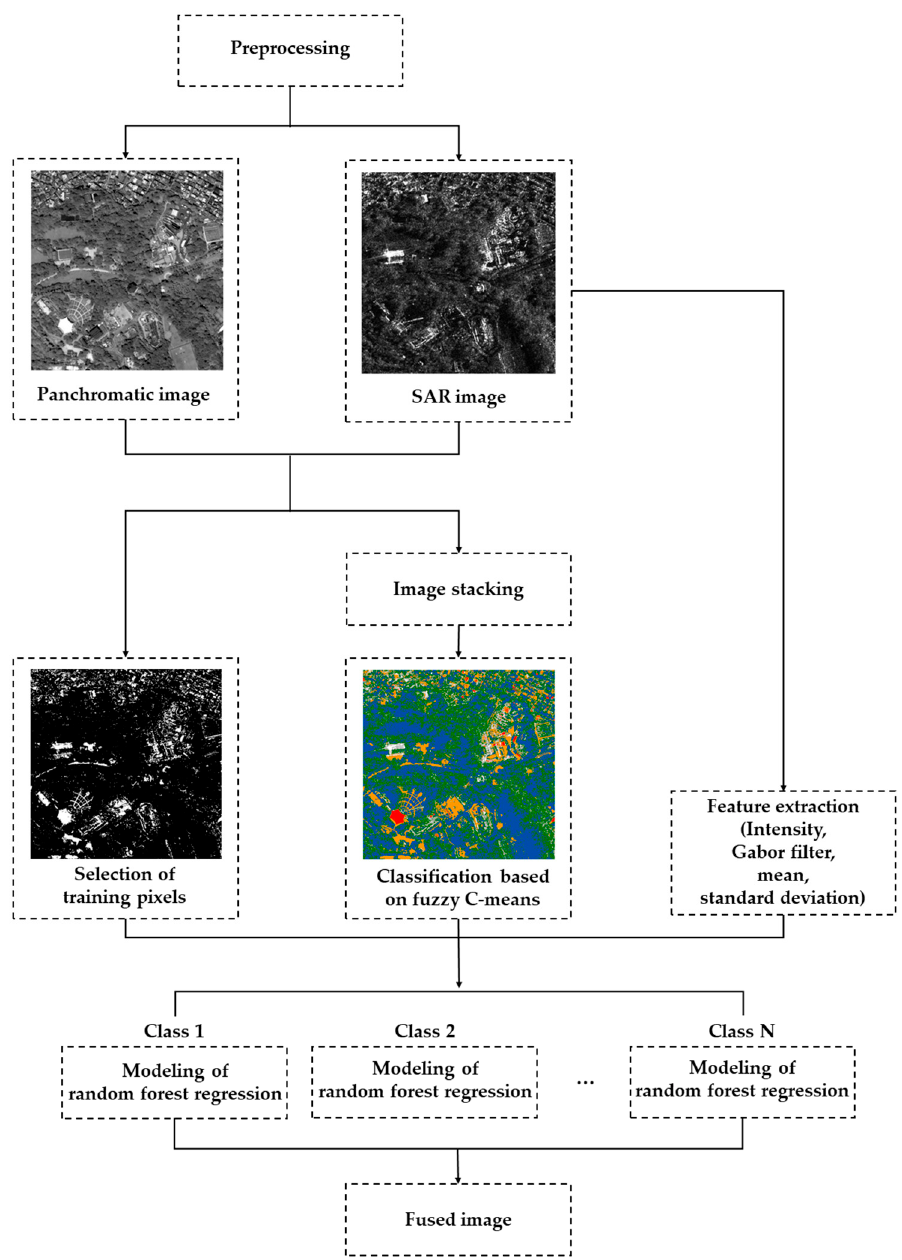
Figure 5. Flowchart of the proposed method.